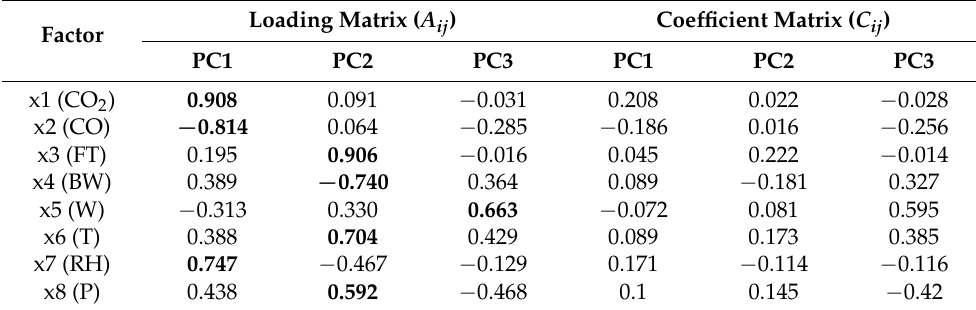
Table 3. Factor loading matrix of